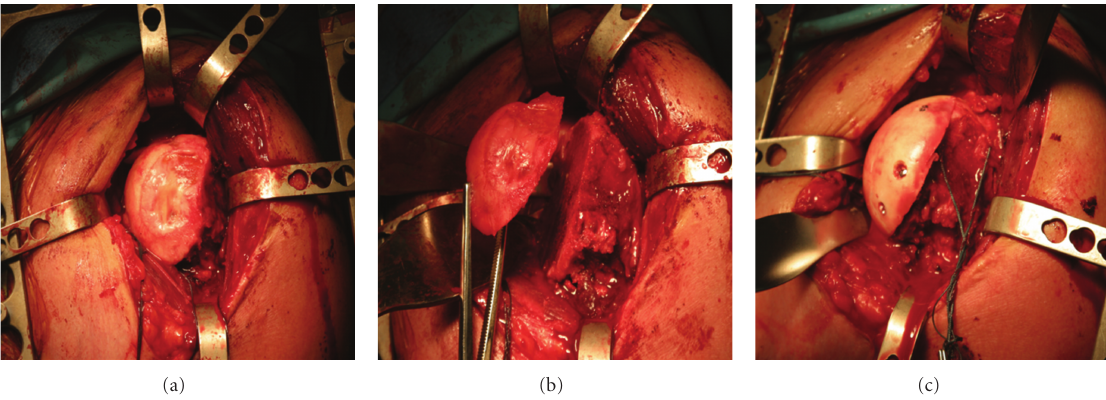
Figure 5: Large humeral head cartilage defect (a), excised (b) and replaced with an osteochondral allograft (c) in a patient younger than 50 years